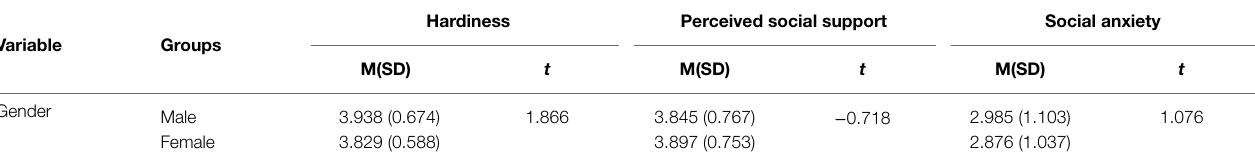
TABLE 6 | Differential analysis for gender in all